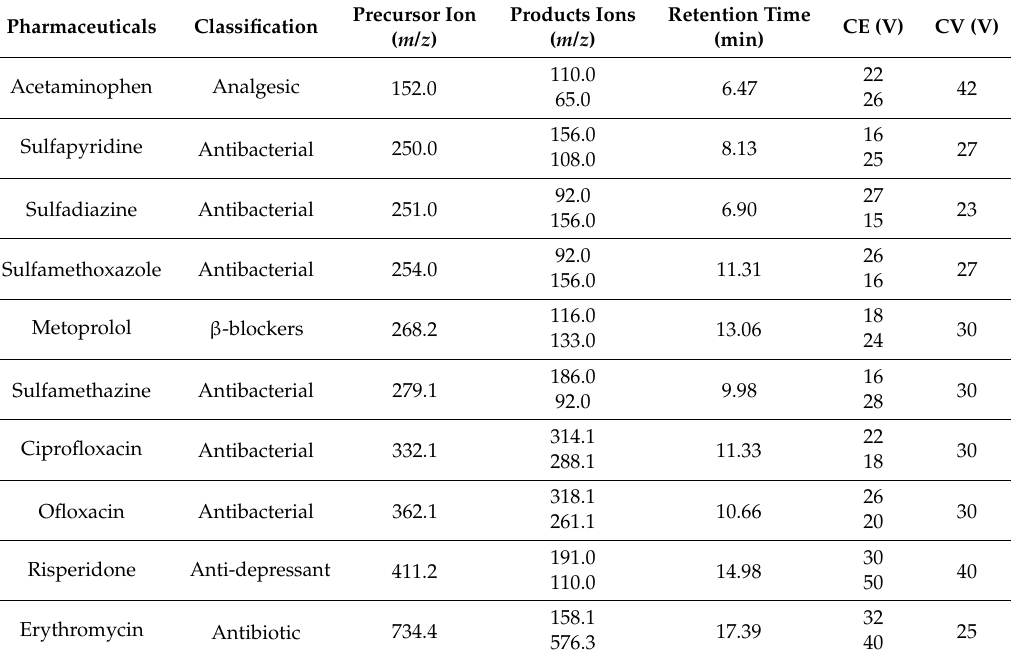
Table 7. MRM and MS parameters for all analyzed